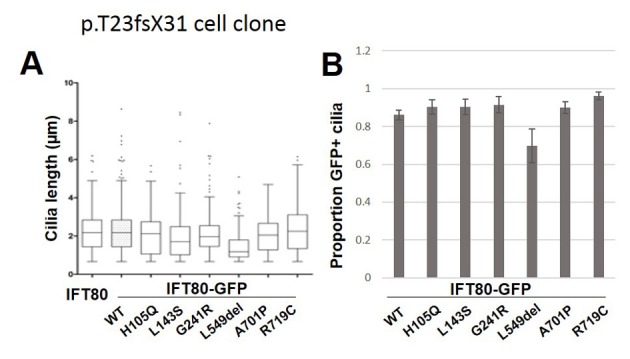
Quantification of functional rescue experiments in a second independent Ift80 mutant cell clone.(A) Quantification of cilia length (Arl13b) shows that transfection of untagged WT mIFT80 rescues failed ciliogenesis to the same degree as mIFT80-GFP in a cell clone homozygous for the p.T23fsX31 mutation. All mutants rescued ciliogenesis to the same degree as WT (n = 3 biological replicates; error bars are standard deviations). (D) Quantification of the proportion of GFP +cilia co-localizing with Arl13b staining following transfection of different mIFT80-GFP point mutations. (n = 3 biological replicates; error bars are standard errors of the mean).